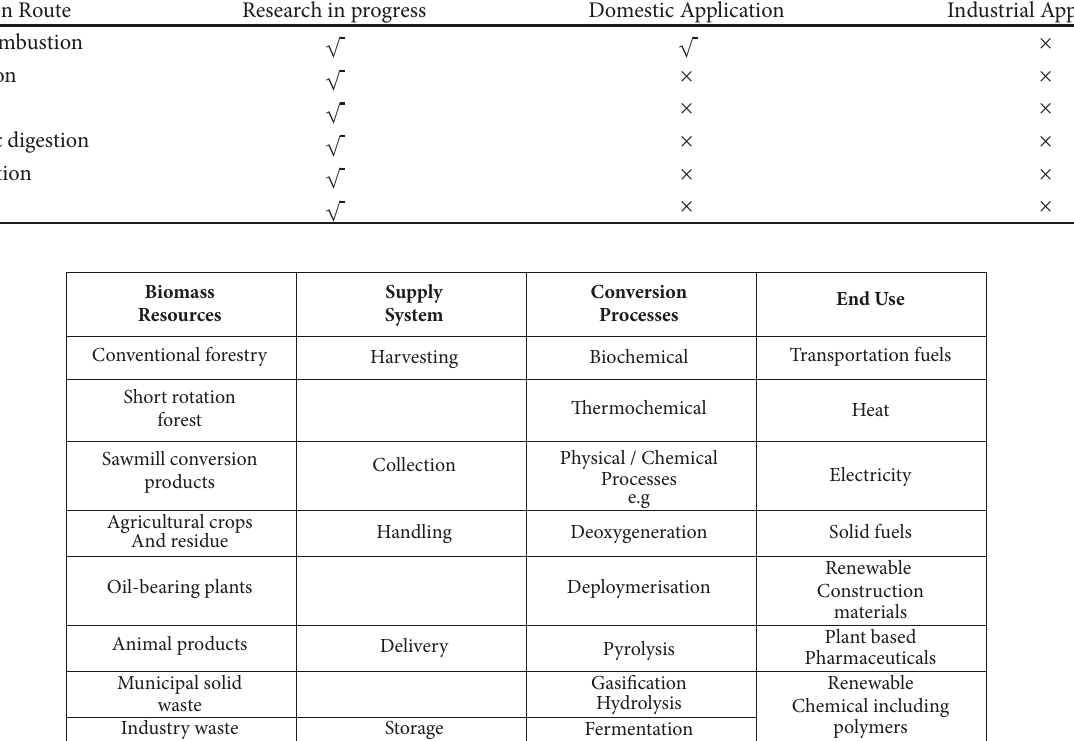
Figure 4: Biomass conversion technologies, products, and applications. Source: UK Biomass Strategy